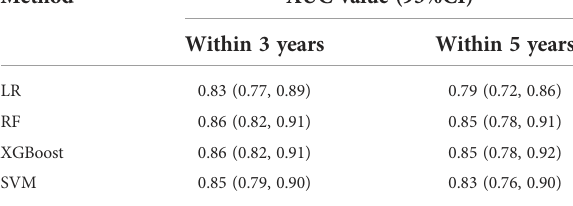
TABLE 3 AUC value comparison of Chinese medicine intervention prognostic model. Method